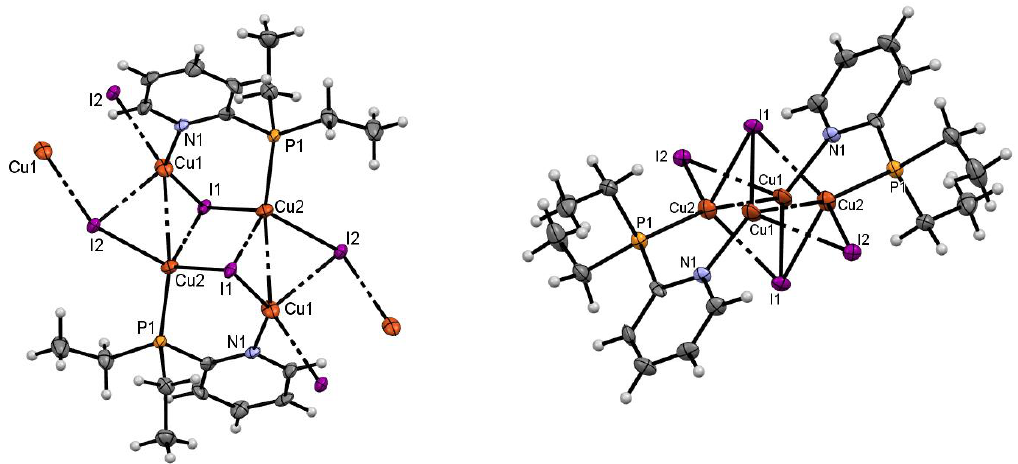
Figure 2. The structure of coordination polymer 2 , shown in two projections.